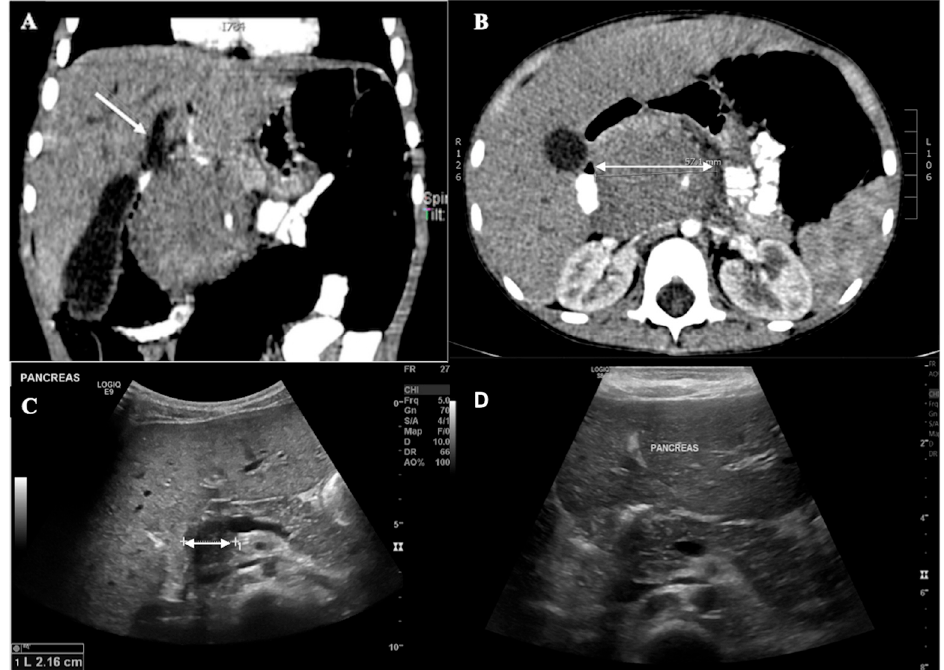
Figure 1. ( A , B ): Axial and coronal contrast enhanced CT images of the abdomen show a well-de- fined large round homogenous mass at the region of the pancreatic head measuring 5.2 cm × 5.7 cm × 6.1 cm displacing adjacent structures and encasing superior mesenteric artery, with upstream bil- iary tree dilatation (arrow). ( C ): Greyscale axial ultrasound image at the level of pancreatic head after starting chemotherapy obtained on day 17 shows mass size reduction measuring 3.4 cm × 3 cm × 2 cm, with reduced upstream biliary tree dilatation. ( D ): Grey scale ultrasound image after induc- tion 2 showed no songoraphic residual mass, with resolved biliary tree